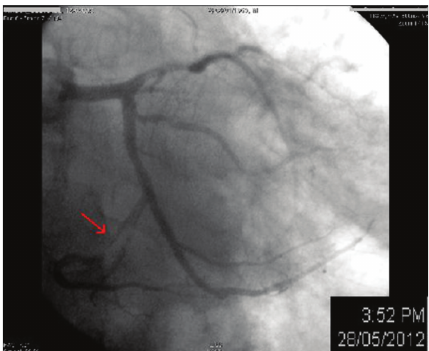
Figure 2: Coronarography showing a near total occlusion of the circumflex artery (red arrow).